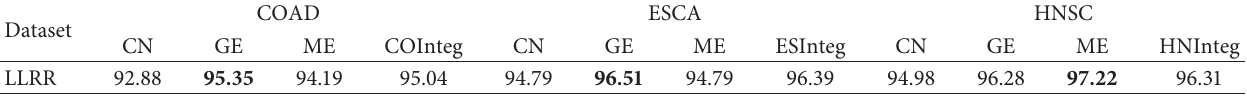
Table 2: The clustering accuracy of LLRR on single genome data and integrated multigenome data.